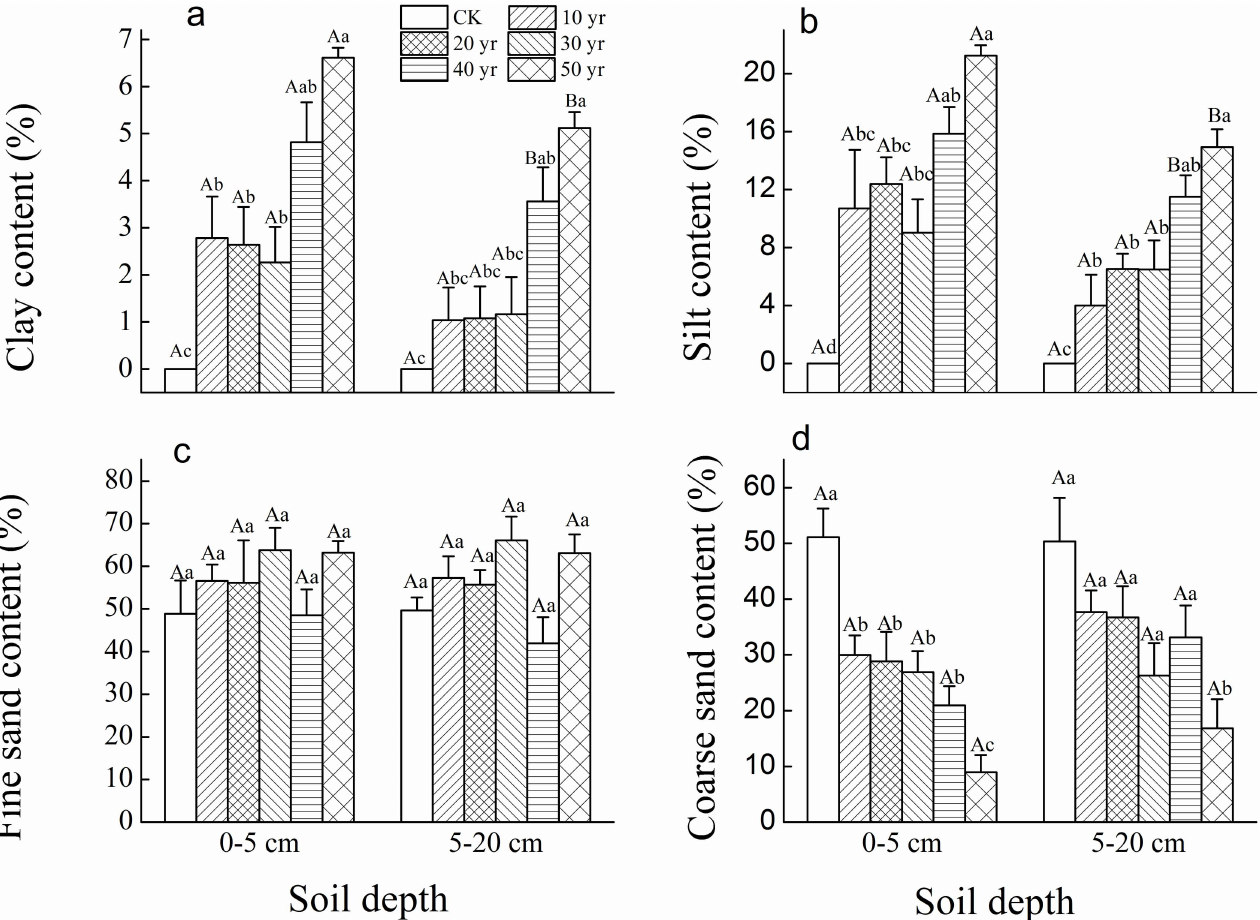
Fig 2. Changes in soil particle size distribution (%, mean ± SE) at 0–5 cm and 5–20 cm soil depths in plantations of different ages and mobile sand dune (CK). (Different uppercase letters indicatesignificantdifferences in soil propertiesbetweentwo soil depths in the same plantation age at p < 0.05.Different lowercaseletters indicatesignificantdifferencesin soil propertiesamongdifferent plantationages with the same soil depth at p <